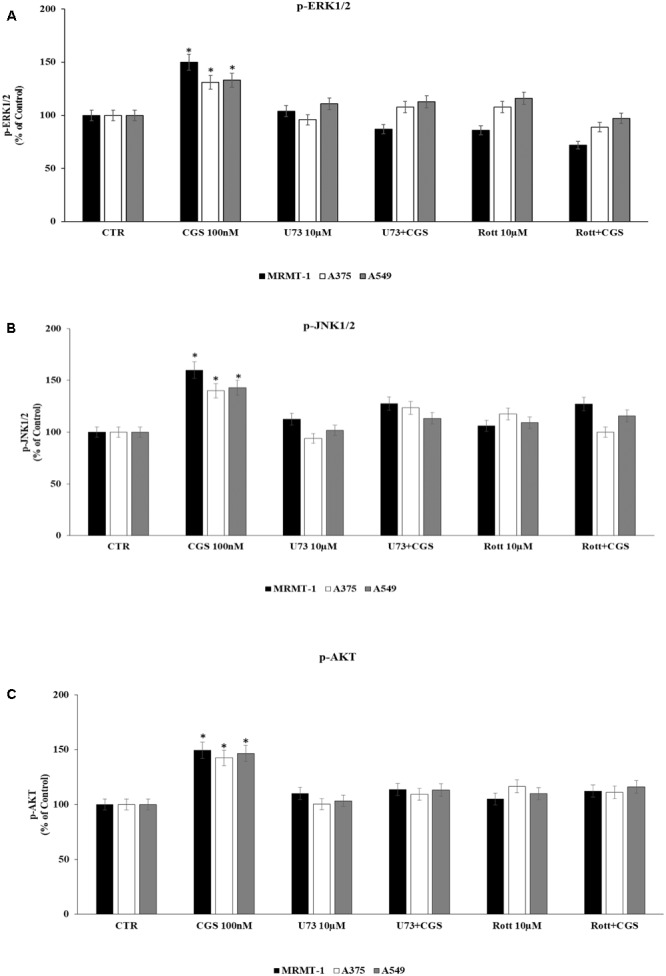
Effect of 100 nM CGS 21680 on pERK1/2 (A), pJNK1/2 (B), and pAKT (C) protein levels in MRMT-1, A375 and A549 cells and antagonism by 10 μM U73122 (U73) and 10 μM rottlerin (Rott) evaluated by AlphaScreen SureFire pMAPK assays. Solutions were made up in DMSO and then diluted in cell culture medium (0.1 max 0.2% of DMSO). An equal amount of DMSO was used in control cells (CTR). ∗P < 0.01 compared with CTR. Means ± SE values from four experiments are shown. Analysis was by one-way ANOVA followed by Dunnett’s test.